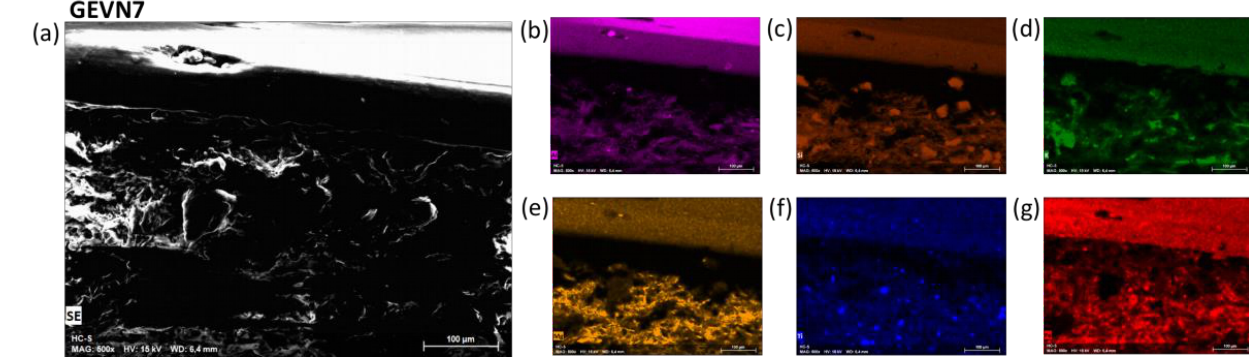
Figure 6. ( a ) SEM image of sample GEVN7; maps of ( b ) Al, ( c ) Si, ( d ) K, ( e ) Mg, ( f ) Ti and ( g ) Fe.